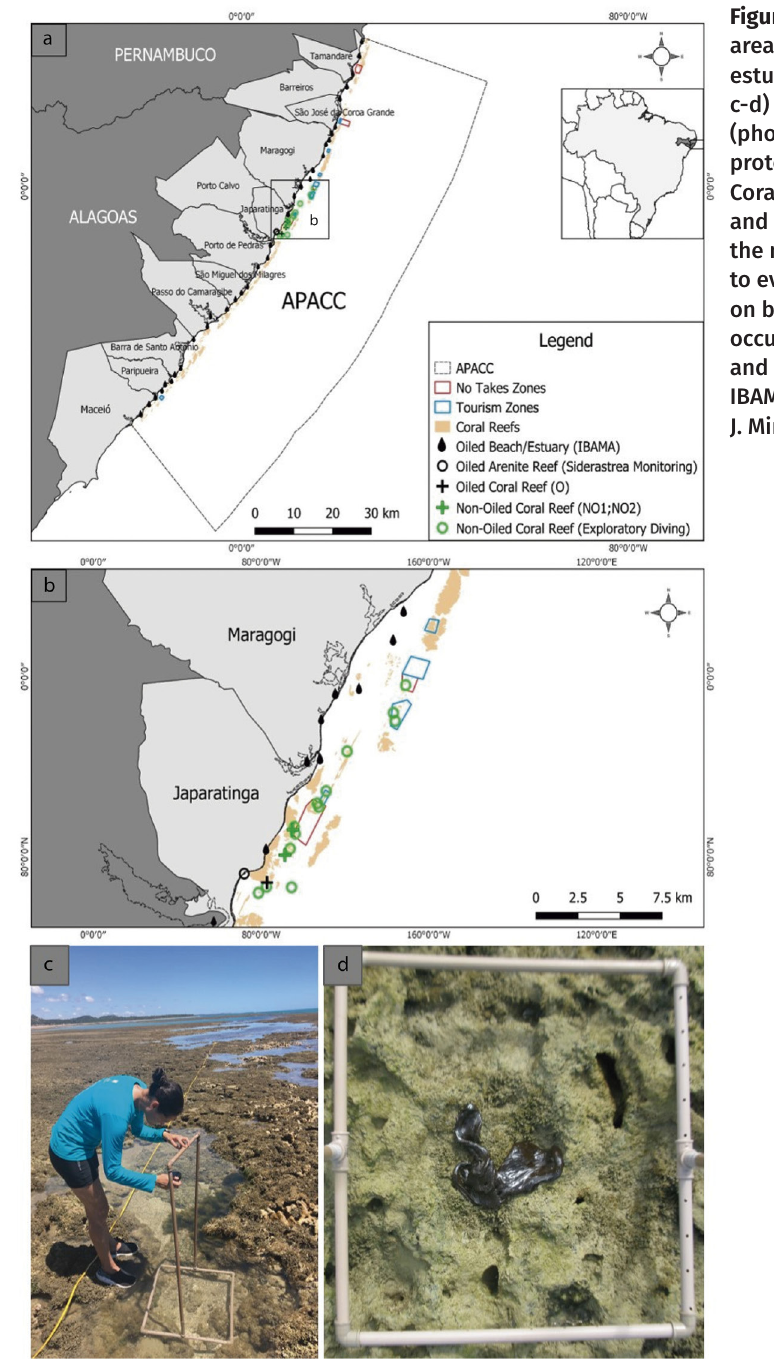
Figure 1. a-b) Map of study area, oil occurrence (beach, estuary and reef sites) and c-d) sampling approach (photo quadrats) in marine protected area Costa dos Corais (APACC), Brazil. O, NO1 and NO2 represent sites of the mensurative experiment to evaluate oil spill effects on benthic assemblages. Oil occurrence data on